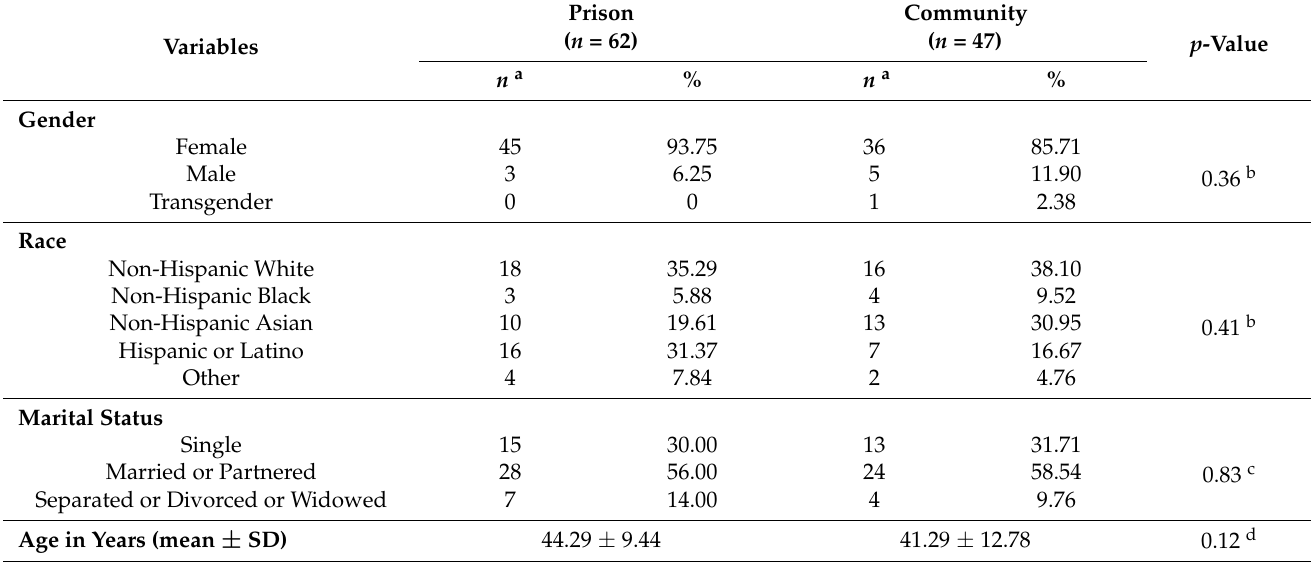
Table 1. Sociodemographic data.